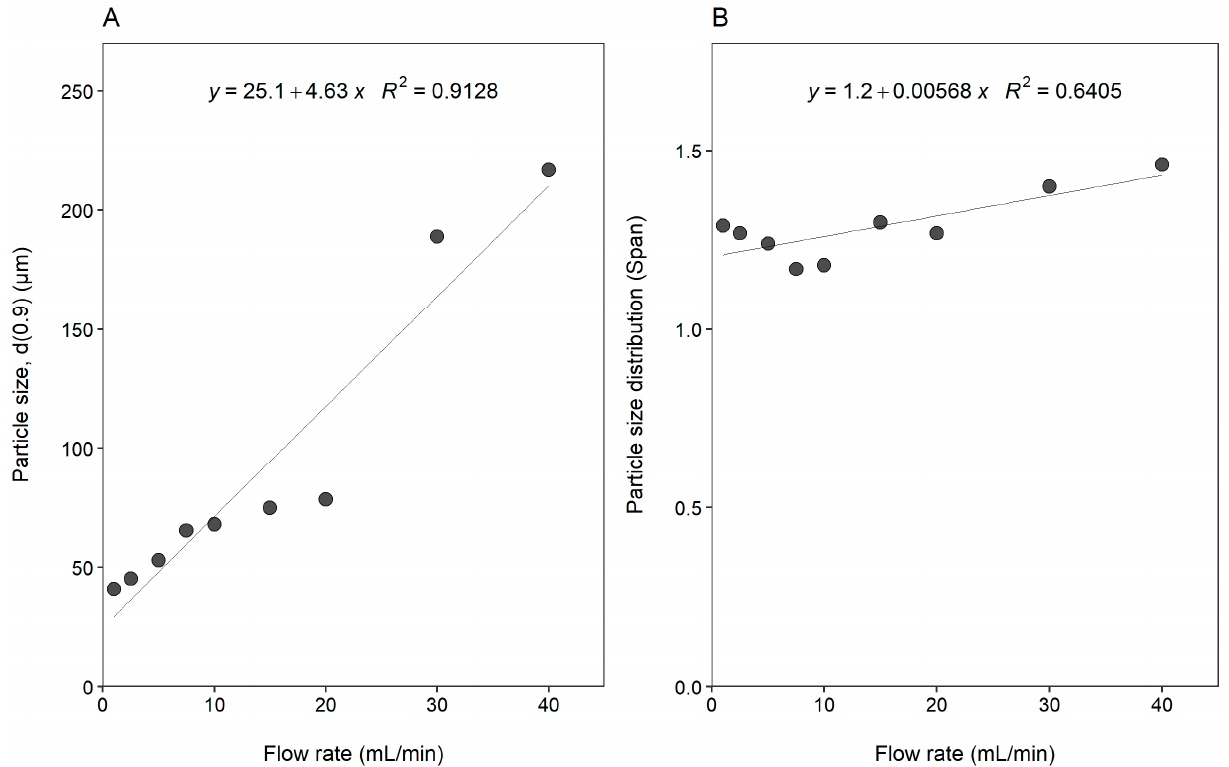
Figure 4. The effect of flow rate (mL/min) on ( A ) particle size (d(0.9)) and ( B ) particle size distribution (Span).